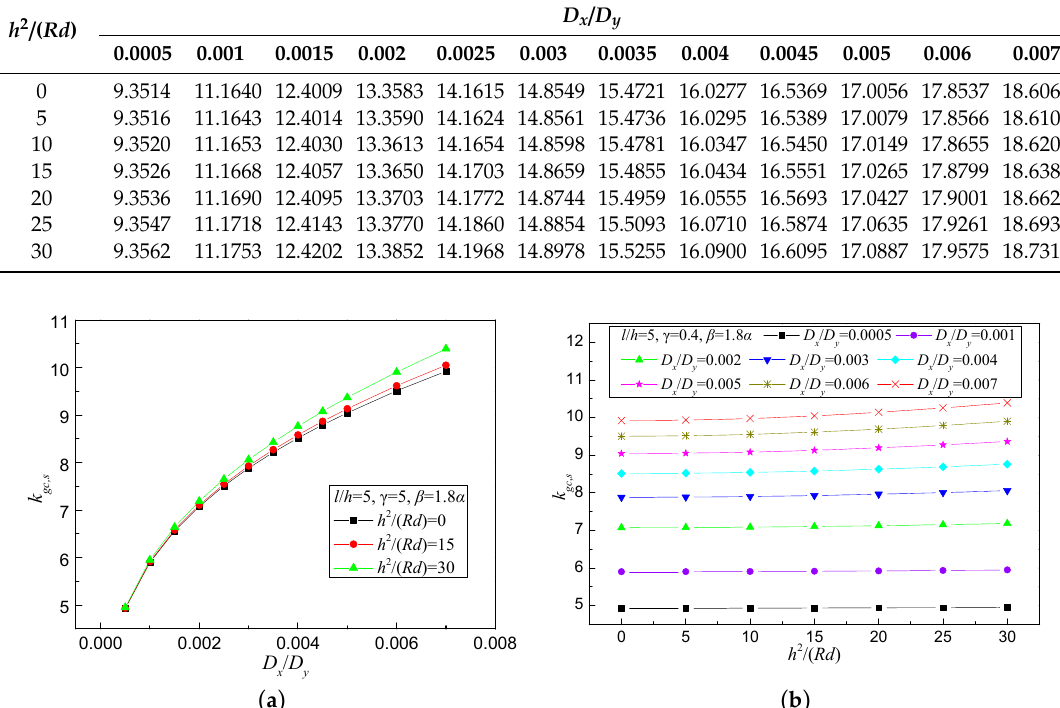
/ D 2 / ( Rd ) on the global shear buckling coe ffi cient k x y and h